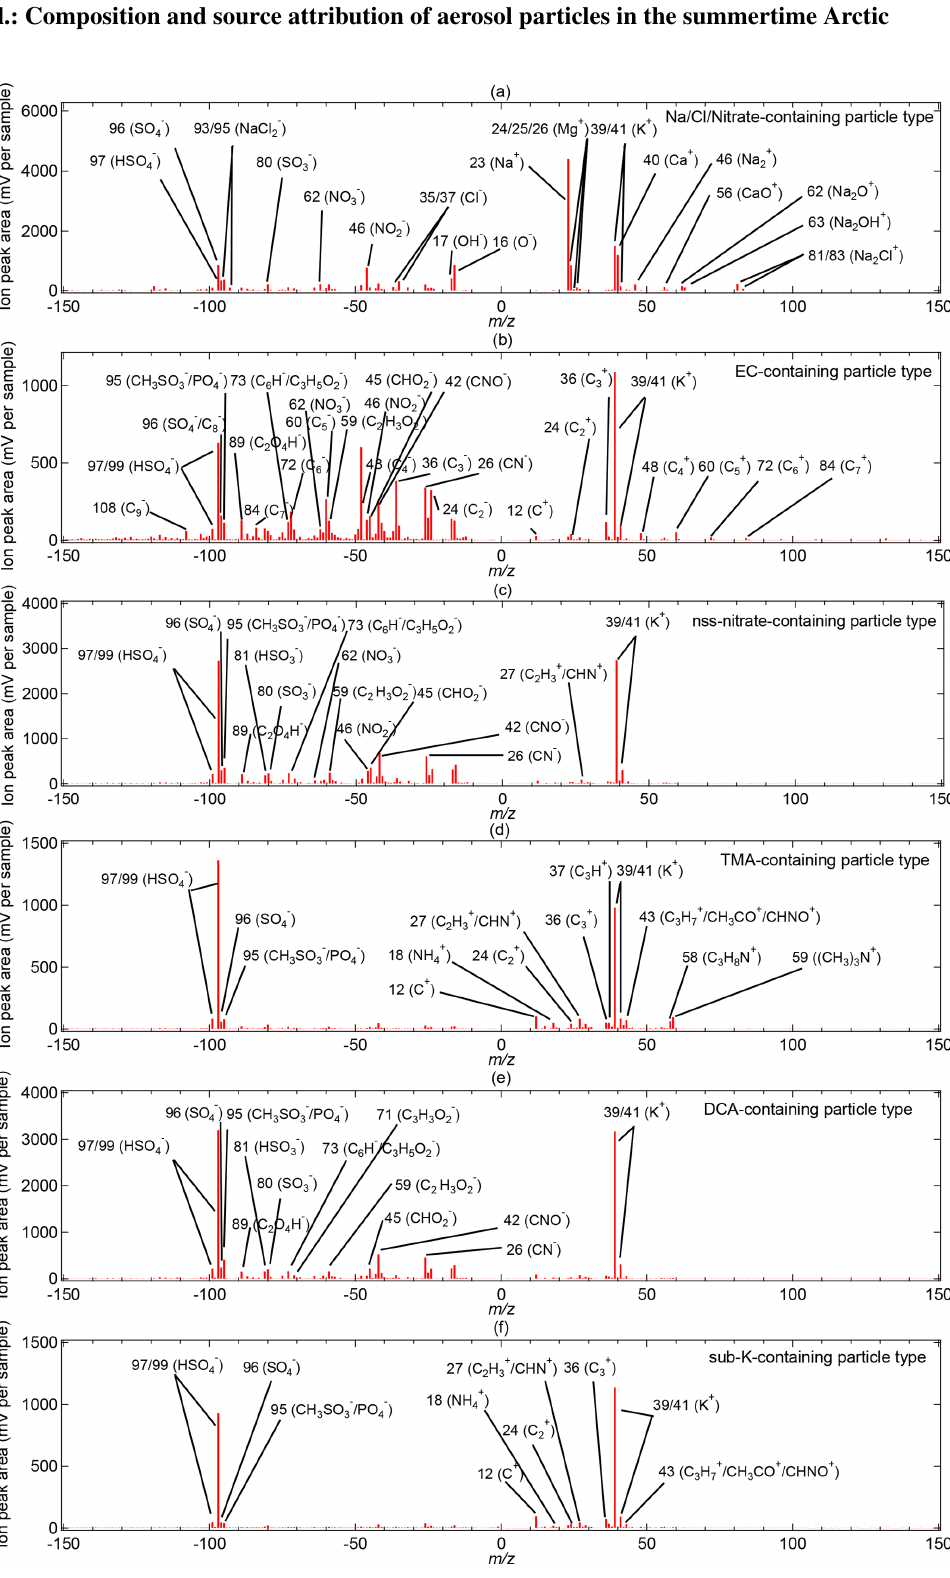
Figure 5. Bipolar mean spectra of the ALABAMA particle types: (a) Na/Cl/Nitrate-containing (195 particles out of 10137 (cid:98) = 2%), (b) EC- containing (188 particles out of 10137 (cid:98) = 2%), (c) nss-nitrate-containing (688 particles out of 10137 (cid:98) = 7%), (d) TMA-containing (2325 particles out of 10137 (cid:98) = 23%), (e) DCA-containing (3150 particles out of 10137 (cid:98) = 31%), and (f) sub-K-containing (2210 particles out of 10137 (cid:98) =